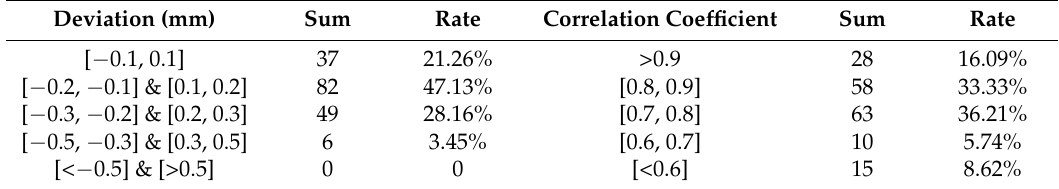
Table 1. Statistics of the calculated deviation and correlation